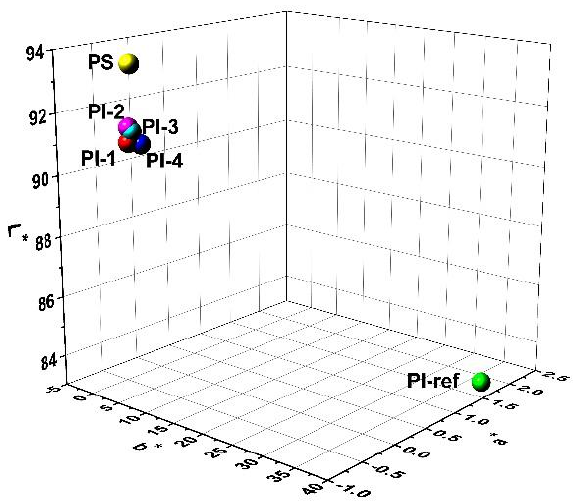
Figure 8. Three-dimensional (3D) plots of the CIE Lab parameters for electrospun PI, PI-ref, and PS membranes.